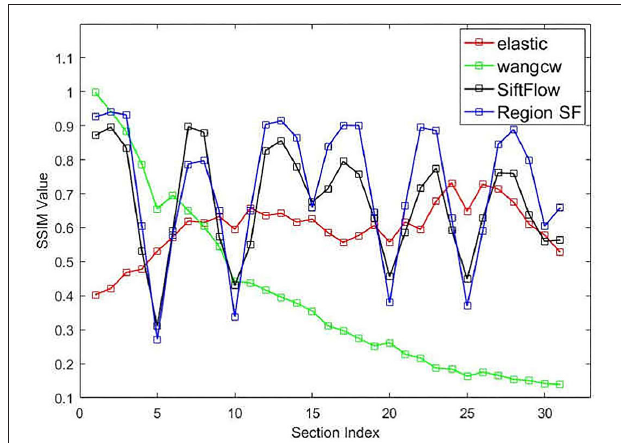
FIGURE 9 | Structural similarity index (SSIM) between the aligned sections and the ground truth.